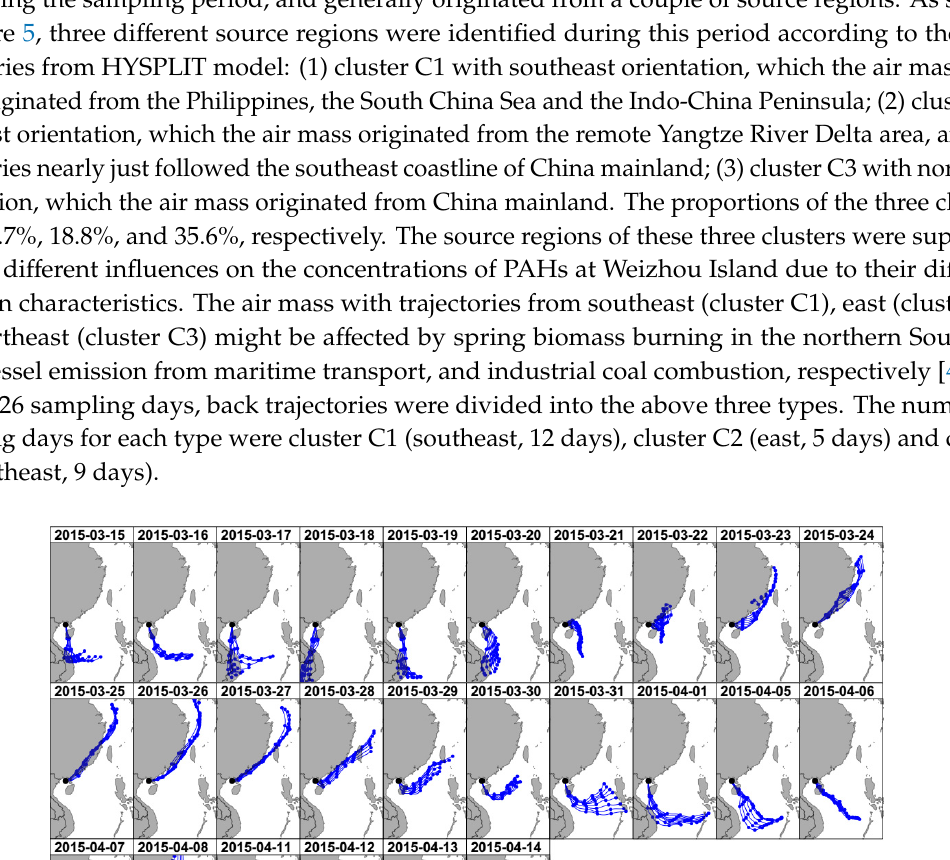
Figure 5. The 3-cluster solution to back trajectories calculated for the Weizhou Island from 15th March to 14th April. As the emission profiles of PAHs congeners strongly depend on their formation mechanisms during the production process of different PAHs such as diesel and gasoline combustion, crude oil processing and coal combustion, diagnostic ratios are frequently used to distinguish different